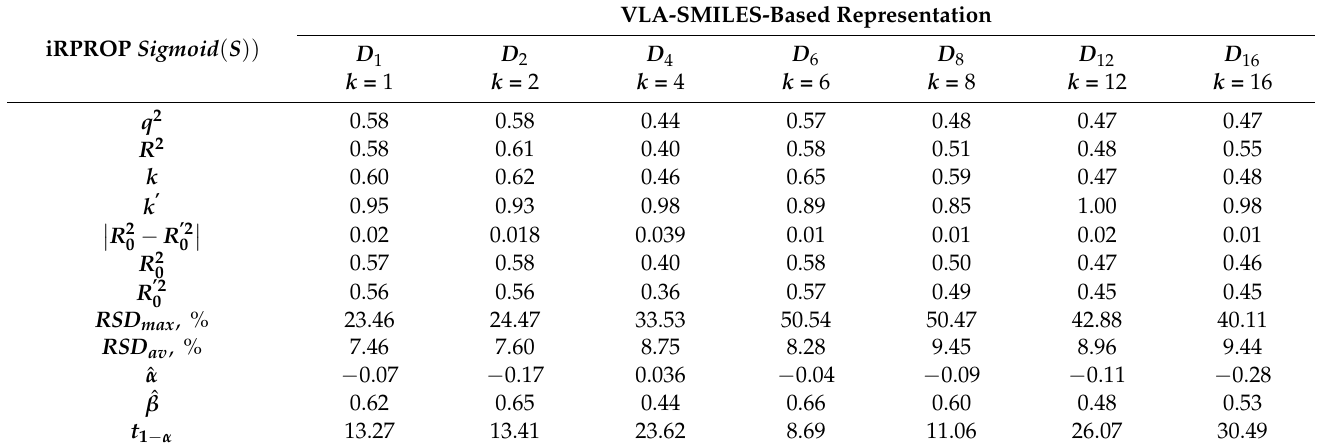
Table 6. Statistical parameters derived for model predictive ability assessment (single-layered MLP with iRPROP learning and Sigmoid activation), Dataset#1.